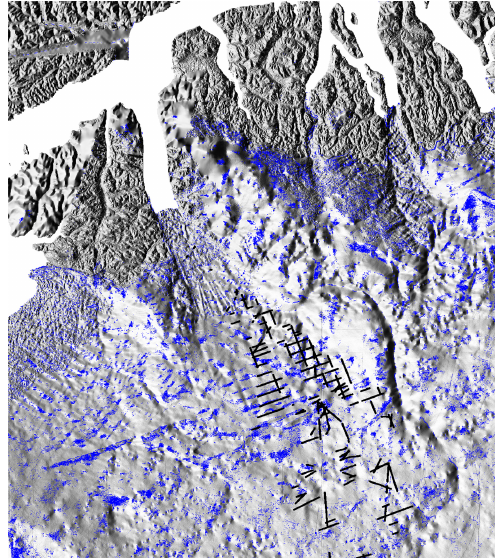
Figure 7. Closeup of Petermann Glacier region at 150m resolution. Gray base map is shaded relief of hydropotential gradient. Blue dots and black lines are locations of basal freeze-on predicted by the model and from Bell et al. (2014) respectively. Each blue dot is a 150m × 150m square